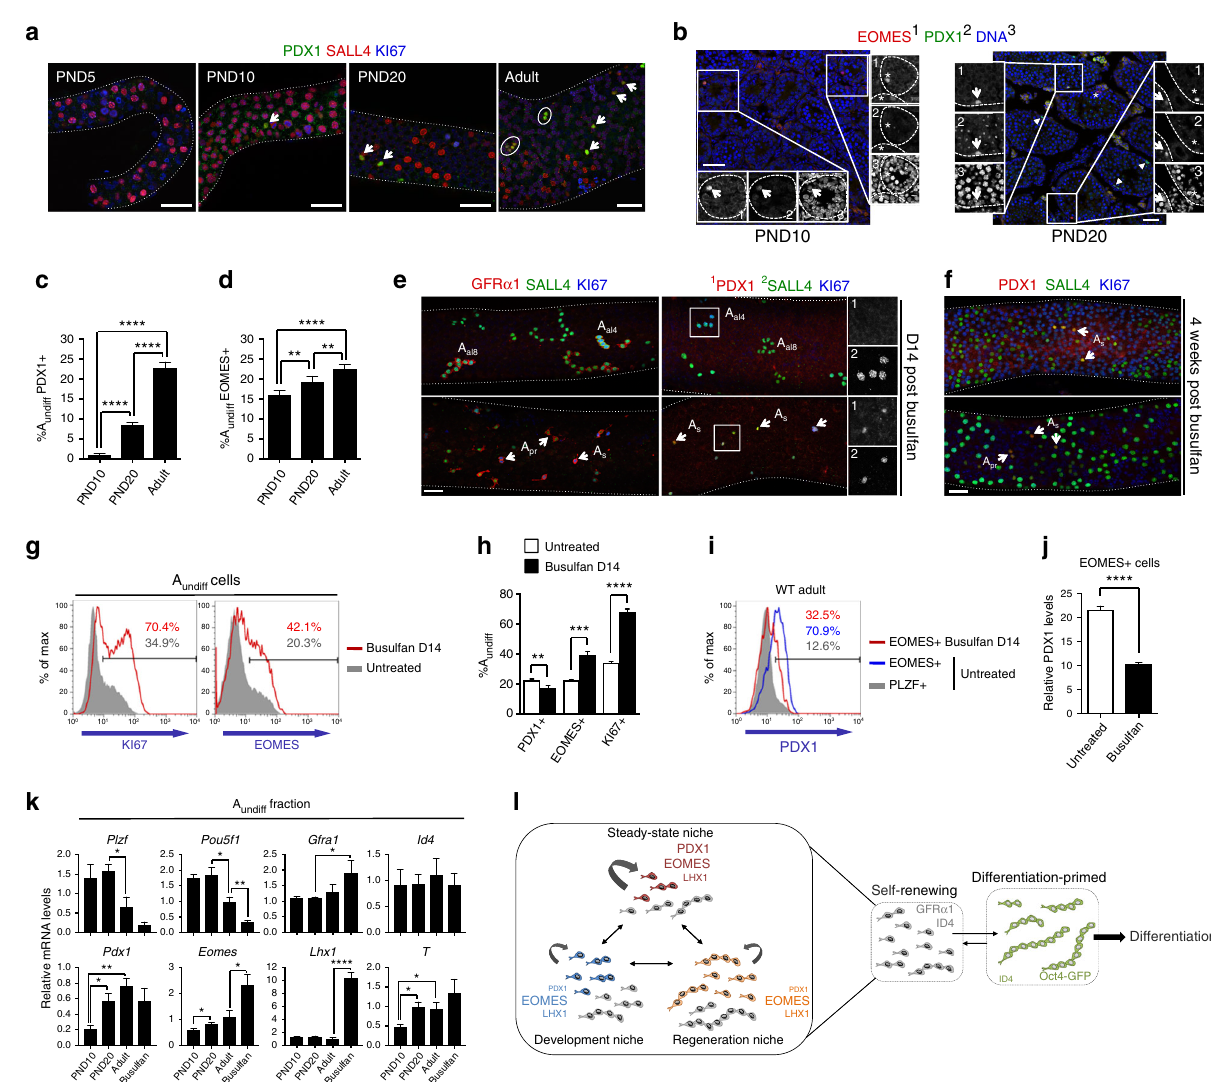
Fig. 7 PDX1 + and EOMES + spermatogonia during development and regeneration. a Representative whole-mount IF of tubules from WT mice of indicated ages (PND; postnatal day) ( n = 2 mice per age). Scale bars, 50 μ m. b Representative IF of testis sections from WT mice of indicated ages ( n = 3 mice per timepoint). Insets show details of indicated areas. Arrowheads: EOMES + PDX1 + cells. Asterisks: EOMES + PDX1 − cells. Scale bars, 50 μ m. c , d Flow cytometry of fi xed and permeabilized testis cells from WT mice of indicated ages. Mean percentages of PLZF + c-KIT − A undiff expressing PDX1 and EOMES are shown ± s.e.m. ( n = 3 – 5 mice/time point). e WT adults were treated with busulfan (10 mg/kg) and tubules analysed by whole-mount IF 14 days later ( n = 2 mice). Top panels: regenerative areas with GFR α 1 + A al . Bottom: non-regenerative areas lacking GFR α 1 + A al . Insets show details of indicated regions. Scale bar, 50 μ m. f Regeneration assay of e 4 weeks post busulfan (2 areas shown). Arrowheads: PDX1 + A undiff . Scale bar, 50 μ m. g Representative fl ow cytometry of fi xed and permeabilized testis cells from WT adults untreated or busulfan treated as in e ( n = 4 busulfan-treated mice and n = 5 untreated). PLZF + c-KIT − A undiff are shown. Percentage of A undiff KI67 + and EOMES + are indicated. h Mean percentages of PLZF + c-KIT − A undiff expressing PDX1, EOMES and KI67 from g are shown± s.e.m. i Representative fl ow cytometry of PDX1 in indicated populations from g ( n = 4 mice per condition). Percentages of cells PDX1 + are indicated. j PDX1 levels (median fl uorescent intensity) in EOMES + PLZF + cells from i . Mean values ± s.e.m. shown. k Quantitative RT-PCR of A undiff from Plzf-mC/CreER mice of indicated ages or 10 days post busulfan as in e . Expression levels are corrected to β -actin and normalized to an adult sample. Mean values ± s.e.m. are indicated ( n = 4 PND10 and busulfan-treated, n = 5 PND20, n = 6 adults). Selected signi fi cance values are shown. l Model of A undiff functional states. Self-renewing (curved arrows) GFR α 1 + A undiff adopt different states identi fi ed by variable expression of Pdx1 , Eomes and Lhx1 . A fraction of GFR α 1 + A undiff lacks PDX1, EOMES and LHX1 (grey in panel) and may represent a transitional state destined to become differentiation-primed. Niche signals differentially support self-renewing states. Given dynamic niche properties, different states predominate in development and homeostatic plus regenerative testis. The state marked by PDX1, EOMES and LHX1 is speci fi c to homeostatic testis and potentially optimized for life-long germline maintenance. Pdx1 is downregulated and Eomes plus Lhx1 upregulated in states suited for short-term expansion during development and regeneration. Oct4-GFP + differentiation-primed A undiff convert back to a self-renewing state under optimised culture conditions or by transplantation into recipient testis with vacant niches. Signi fi cance was calculated by two-tailed Student ’ s t -test (* P < 0.05, ** P < 0.01, *** P < 0.001, **** P <